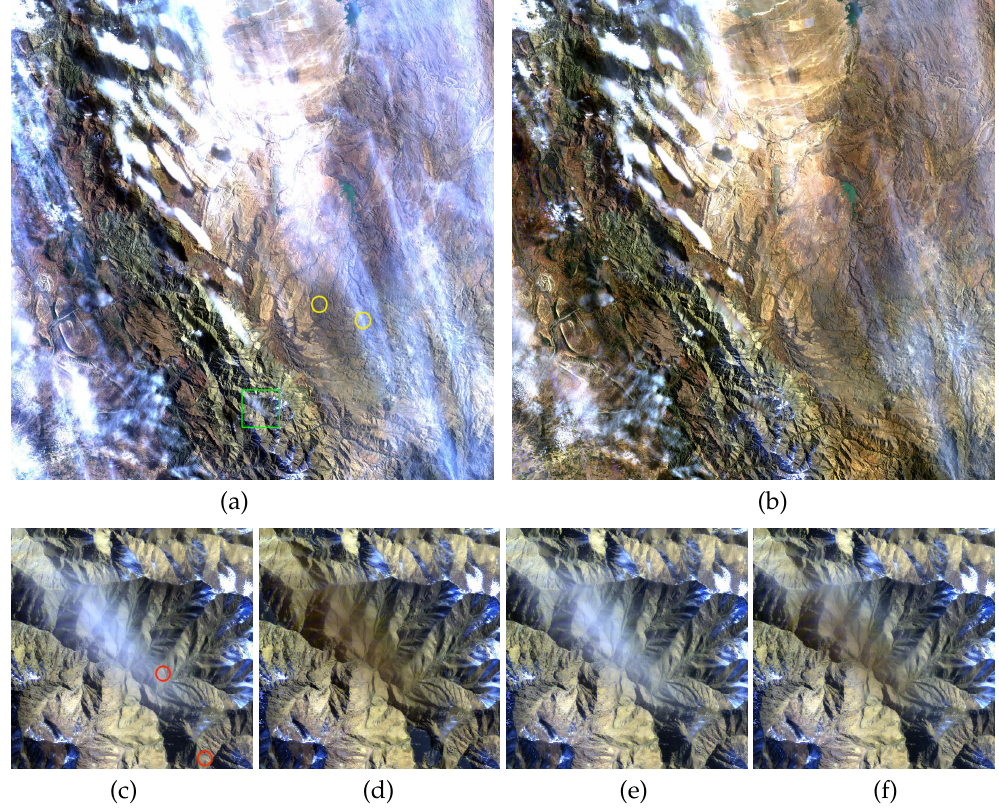
Figure 3. Sentinel-2A scene Morocco (oriented towards east), ( a ): original true color radiance image, ( b ): result of cirrus removal with M2. ( c ): subset of green box true color scene after standard atmospheric correction, ( d ) de-cirrus with standard method, ( e ) de-cirrus with method M1, and ( f ) method M2, respectively. The colored circles indicate locations of sample